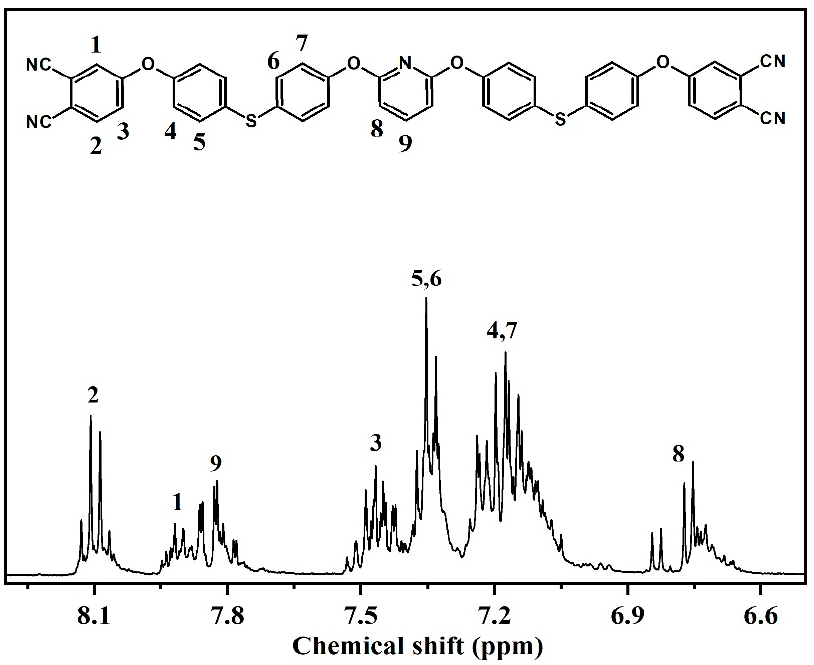
Figure 4. 1 H NMR spectrum of the DPTP monomer. The 13 C NMR spectrum of DPTP monomer is shown in Figure 5. The signals at 116.36 ppm and 115.85 ppm correspond to two cyano-based carbon protons on PN. The signals present at 161.14 ppm, 144.21 ppm, and 109.05 ppm represent carbon protons on the pyridine ring; the rest of the signals signify carbon protons on the benzene ring. Combined with the FTIR spectrum, it could be proven that DPTP is successfully synthesized, with the detailed data of chemical displacement as follows: